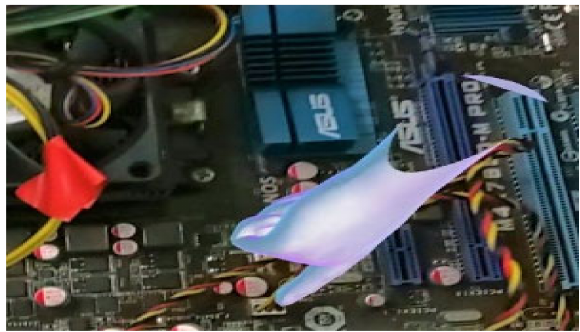
Figure 8. A virtual hand highlights the cable needed to be unplugged.